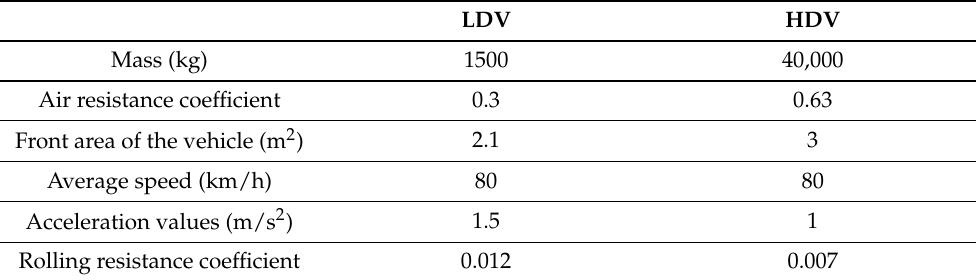
Table 2. Dynamic Energy model: parameters characterization.